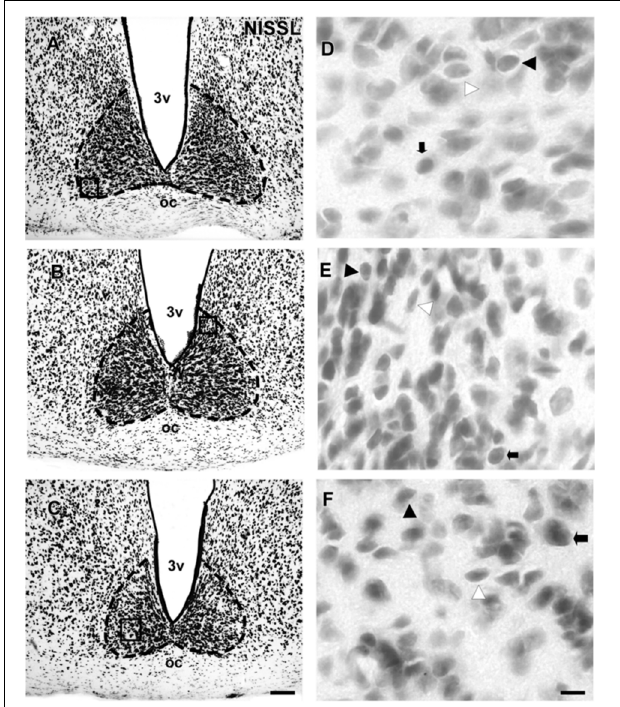
FIGURE 1 | Photomicrographs of the brain sections of flat-faced fruit-eating bat showing the SCN in bright field (A–C) stained by Nissl technique at rostral, middle and caudal levels, respectively. The boxed areas in (A–C) are shown in high magnification in (D–F) , respectively. Black arrowheads point to oval neurons. White arrowhead points to elliptical cells. Black arrow points to spherical neurons. Scale bar 100 µ m (A–C) and 10 µ m (D–F)